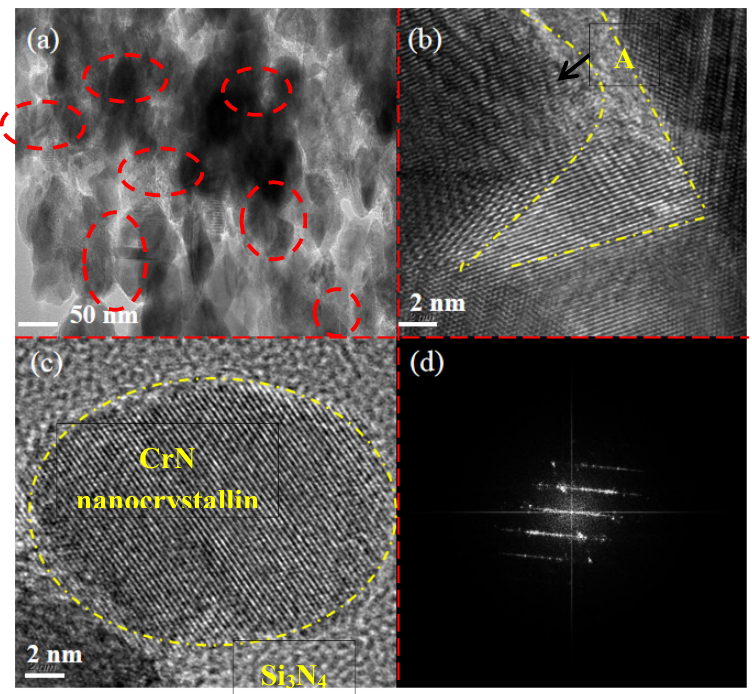
Figure 4. TEM ( a ), HR-TEM ( b , c ) and FFT (fast Fourier transform) images ( d ) of Cr–Si–N coatings deposited under bias voltages of − 100 V. Coatings 2020 , 10 , x FOR PEER REVIEW